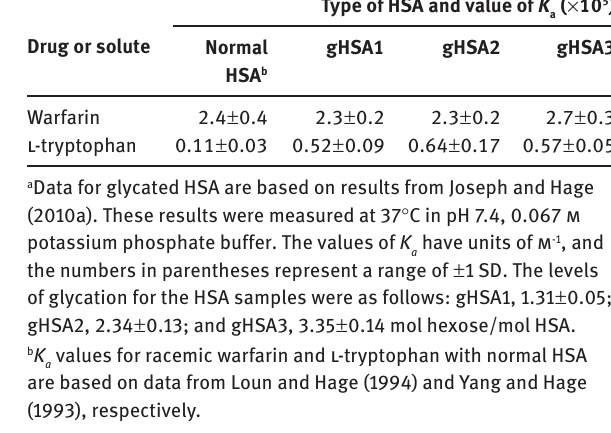
Table 1, the association equilibrium constants that were measured for these samples ranged from 2.3 × 10 5 to 2.7 × 10